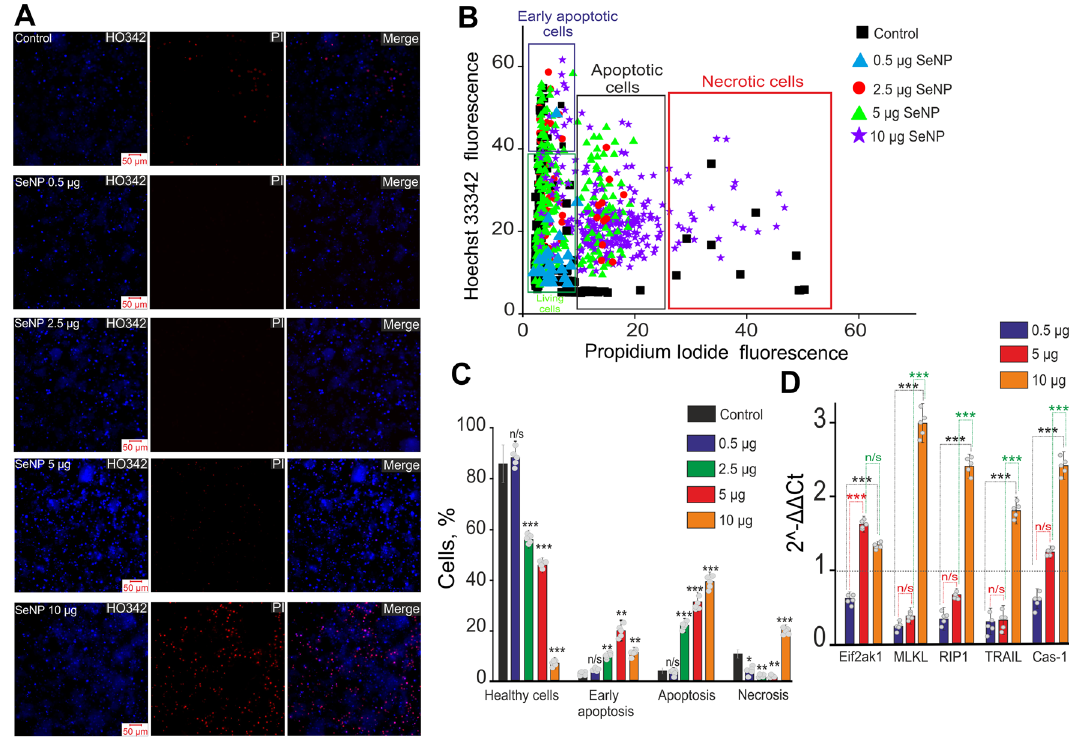
Figure 2. The action of different concentrations of SeNPs on induction of apoptosis and necrosis in the cortical cells. ( A ) Double staining of cells with Hoechst 33342 (HO342), Propidium iodide (PI) and merge (Merge) between Hoechst342 and PI 24 h after SeNPs application. ( B ) Cytogram demonstrating the viability of cortical primary cultured neurons and astrocytes. X-axis—the intensity of PI fluorescence; Y-axis—the intensity of Hoechst 33342 fluorescence. Cells were stained with the probes 24 h after the SeNPs application. ( C ) Effects of different SeNPs concentrations on the induction of necrosis and apoptosis 24 h after SeNPs applications. The percentage of living cells (black column) and cells in which the processes of early apoptosis (violet column), apoptosis (green column), and necrosis (red column) were detected. Each point represents the mean from an individual cell culture. At least 2000 cells were analyzed for each sample. N cell cultures = 5; n coverslips with cells for each sample = 15. Statistical significance was assessed using one-way ANOVA followed by the Tukey– Kramer test. ( D ) Effect of different concentrations of SeNPs on the level of expression of genes encoding marker proteins for necrosis induction. Analyzed 5 samples (5 cell cultures) for each concentration of SeNPs. The horizontal line corresponds to the expression of mRNA of the studied genes in control samples (without SeNPs application). Statistical significance was assessed using one-way ANOVA followed by the Tukey–Kramer test. All values are reliable relative to control (*** P < 0.001). For panels ( C ) and ( D ), results are presented as mean ± SEM. n/s—data not significant ( p > 0.05), * P < 0.05, ** P < 0.01, and *** P < 0.001 compared experimental groups (+ SeNPs) with Control (without